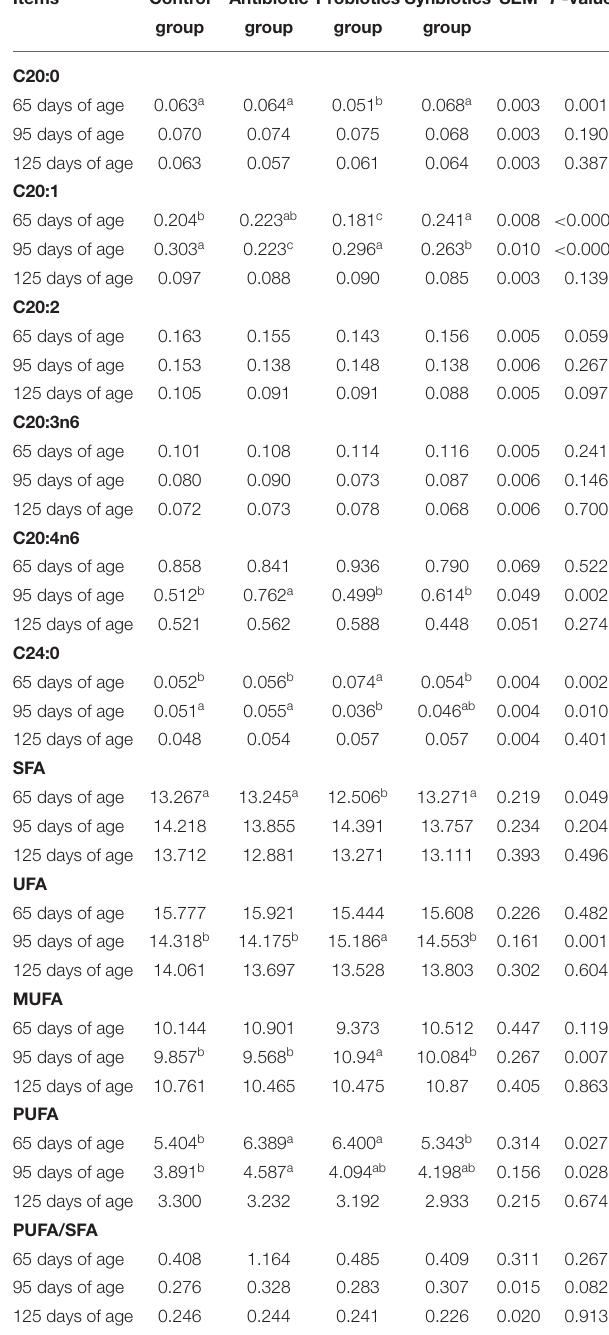
TABLE 5 | Effects of probiotics and synbiotics addition in sows’ diets on intramuscular fat and fatty acid contents in the longissimus thoracis muscle of offspring pigs